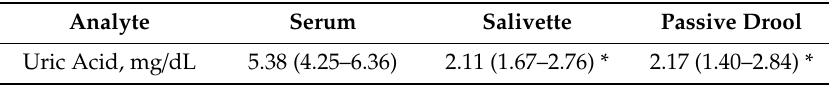
Table 2. Comparison between uric acid values obtained in serum and in saliva using Salivette and passive drool.